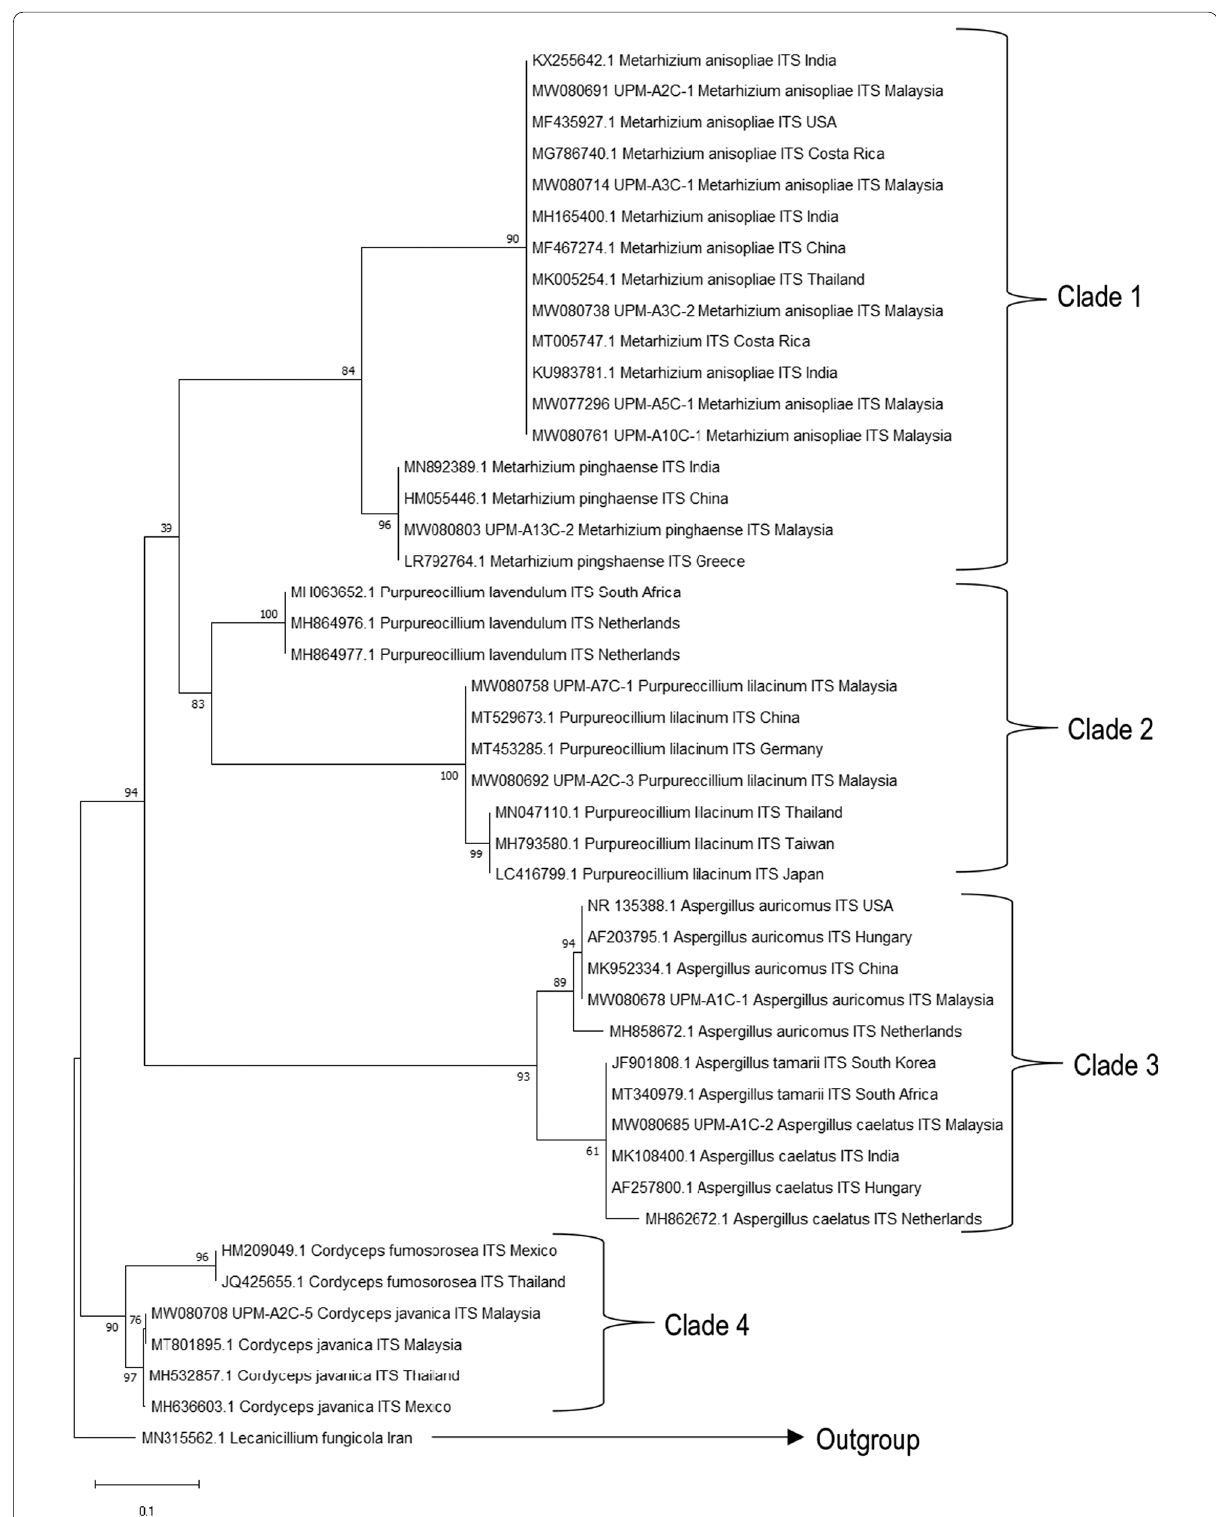
Fig. 2 Phylogenetic tree of ITS gene of EPF. Maximum Likelihood Tree generated based on the combined dataset of ITS nucleotide sequences of UPM EPF isolates developed using MEGA X. Only data with bootstrap value > 30% are shown. Models with the lowest BIC scores (Bayesian Information Criterion) are considered to describe the substitution pattern the best, Kimura 3 parameter model